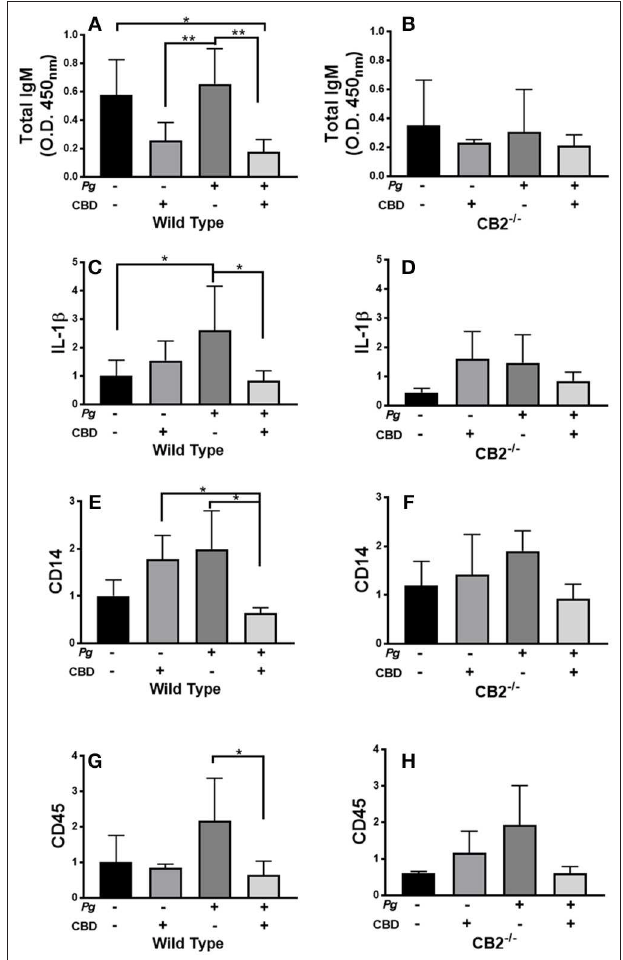
FIGURE 7 | CBD suppresses inflammation induced by repeated oral inoculation with P. gingivalis . CB2 − / − and control groups of C57Bl6 mice ( n = 5 per group) were treated with cannabidiol or vehicle control and repeatedly orally infected with P. gingivalis 33277 or carboxymethyl cellulose control. Total serum IgM was measured by ELISA (A,B) ; and gingival tissue transcripts of inflammation-related biomarkers were detected by qPCR (C–H) . There were no differences in the total IgG or P. gingivalis -cognizant IgM or IgG titers of WT vs. CB2 − / − animals ( data not shown ). Total IgM, IL-1 β , CD14, and CD45 signals differed in WT mice treated with P. gingivalis only compared to those dually treated with bacteria and CBD in WT animals only, all p < 0.05. The IgM signal was generally lower in CB2-deficient animals compared to CB2 replete mice. * / ** p ≤ 0.05/0.01, with all groups compared by